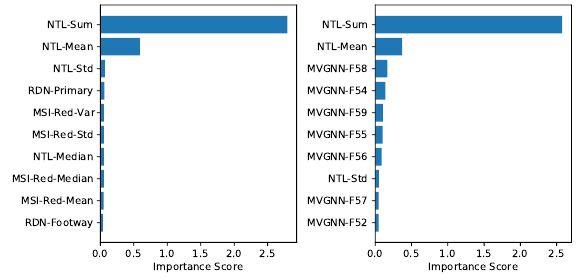
Figure 6. Bar chart of the importance scores of the top 10 contributing features with different input features. Left: ALL , Right: MVGNN+ALL .